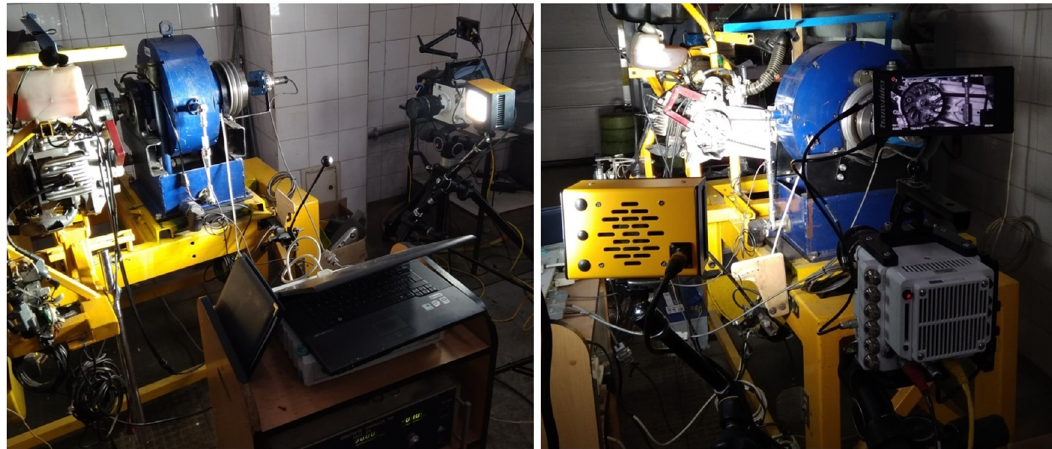
Figure 2: The view of test stand with a high - speed camera.